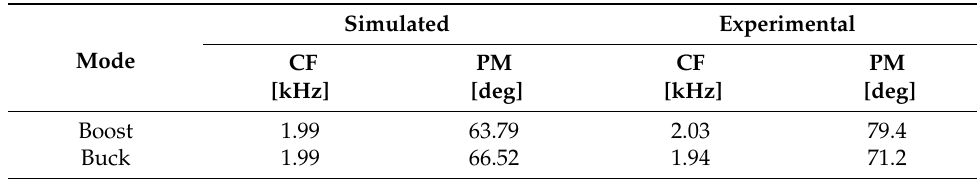
Figure 6. Simulated and experimental voltage loop gain Bode plots of the buck–boost converter. Table 2. CF and PM of voltage loop